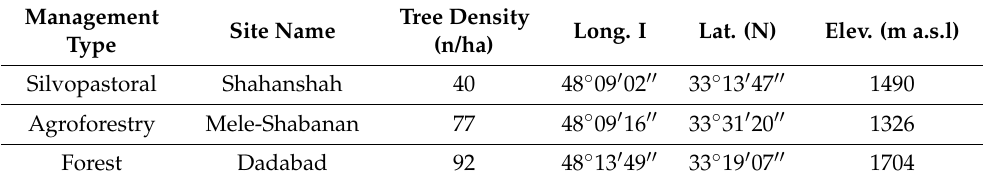
Table 1. Site characteristics including stand density, geographic coordinates, and elevation.